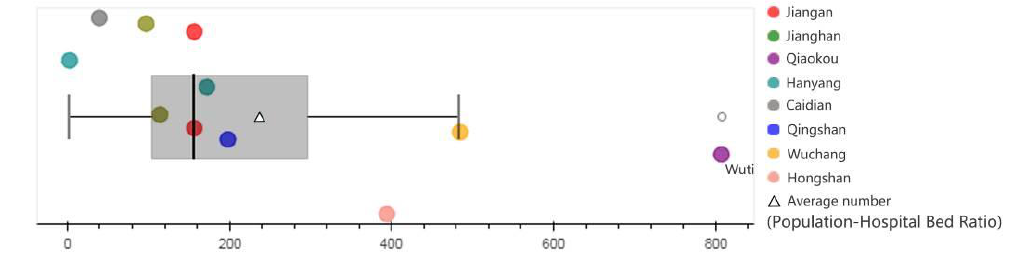
Figure 10. Population–hospital bed ratio of the mobile cabin hospitals (summary unit: district).